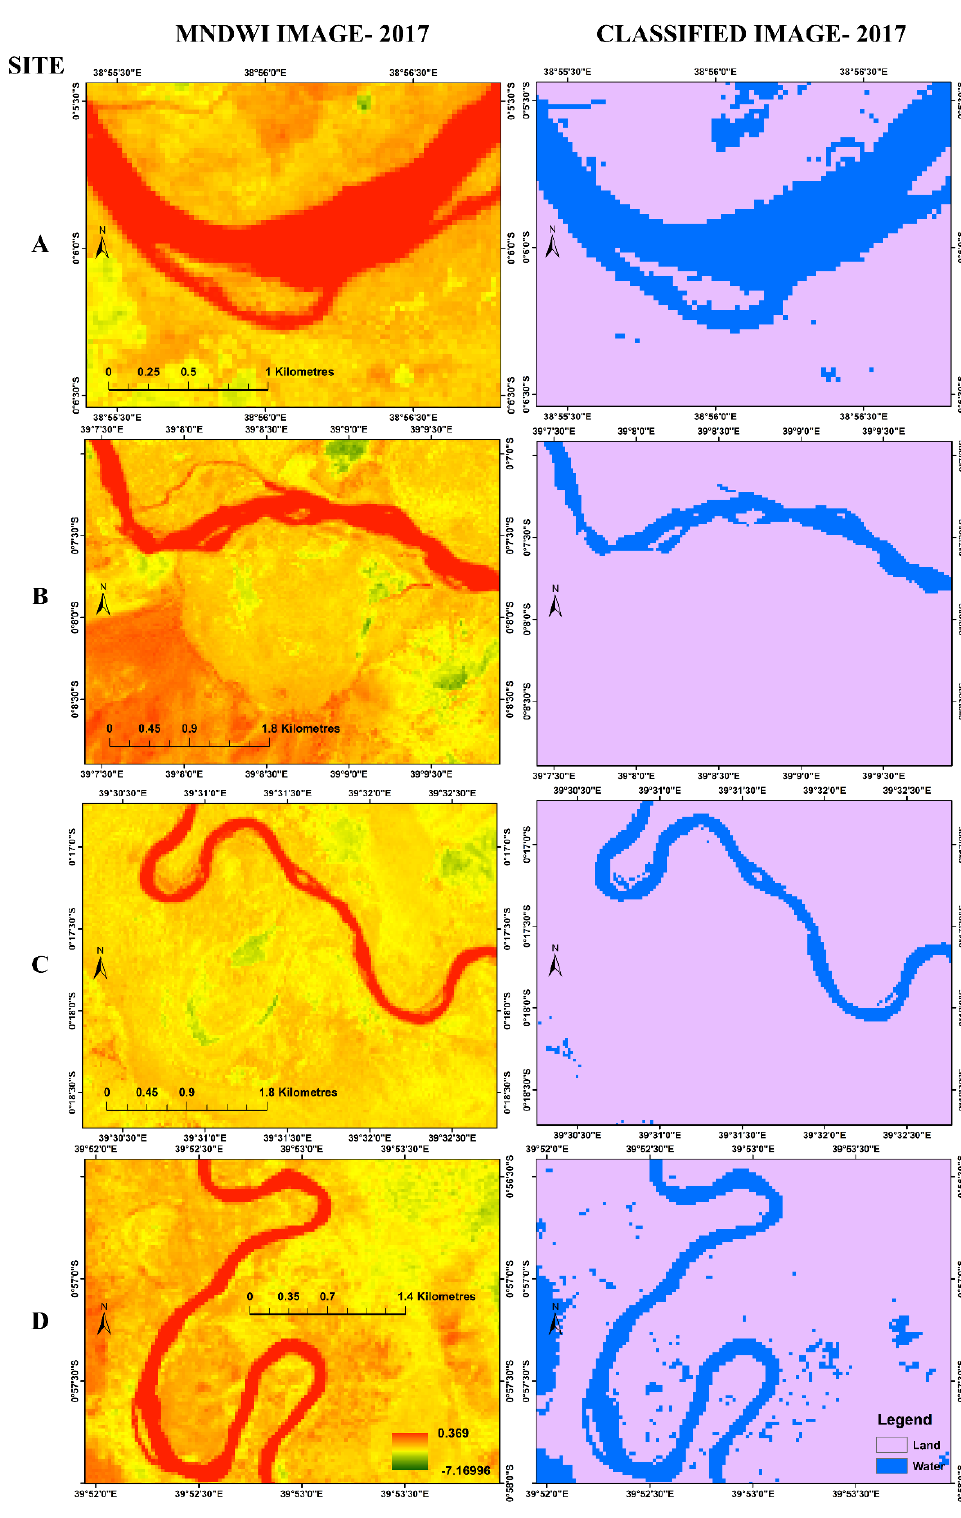
Figure 9. Modified Normalized Difference Water Index (MNDWI) and classified (land and water) images of the study Tana River reach in 2017 .